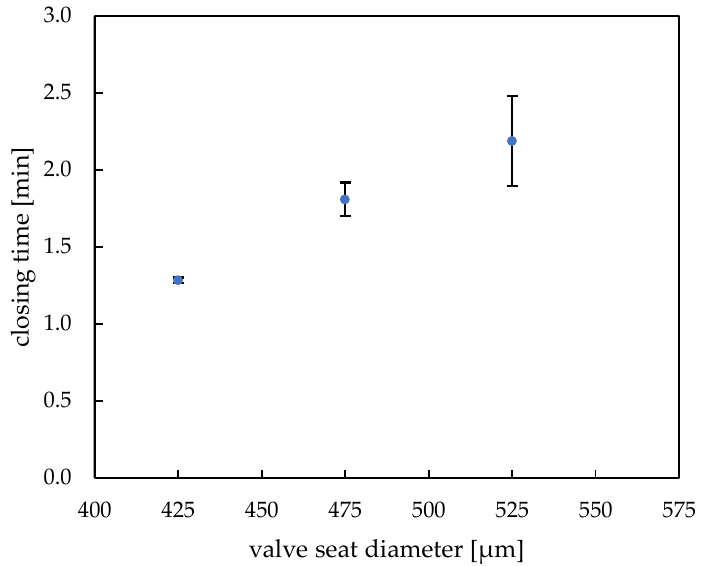
Figure 8. Dependence of hydrogel valve closing time on valve seat diameter (d VS ) (60 s UV exposure time, 400 droplets, ca. 450 pl per drop).